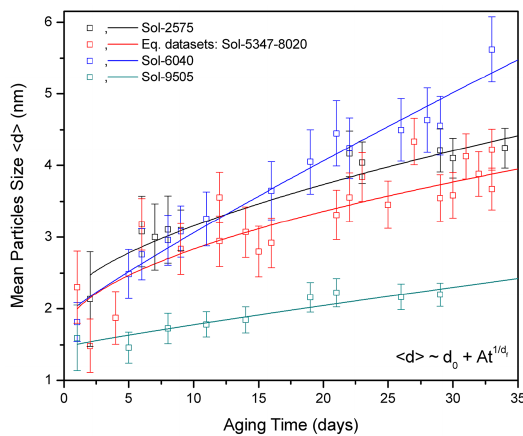
Figure 3. Evolution of the mean particles size as samples aged considering only the statistically independent datasets. Fittings are based on a DLCA aggregation Table 1. Summary of the paired t-tests carried out to our whole datasets. Statistically equivalent groups (p-value > 0.05) are highlighted. Sol-2575